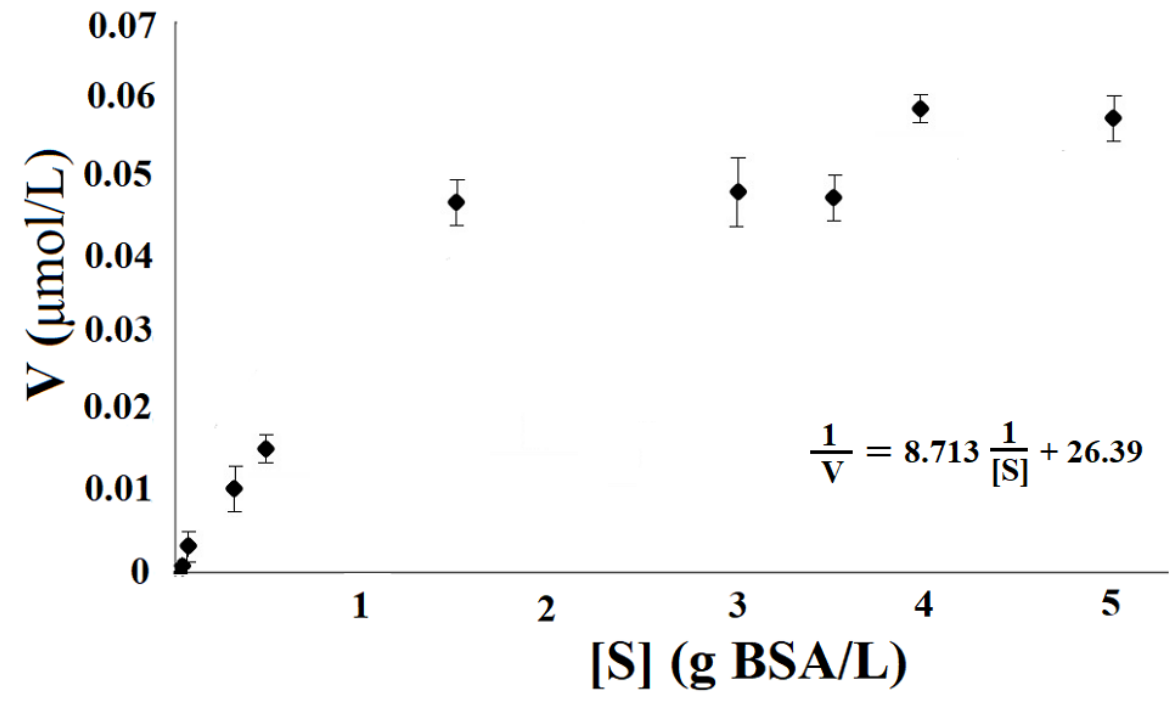
Figure 10. Kinetic of protein hydrolysis by bromelain purified from pineapple at pH 7 and 30 °C.